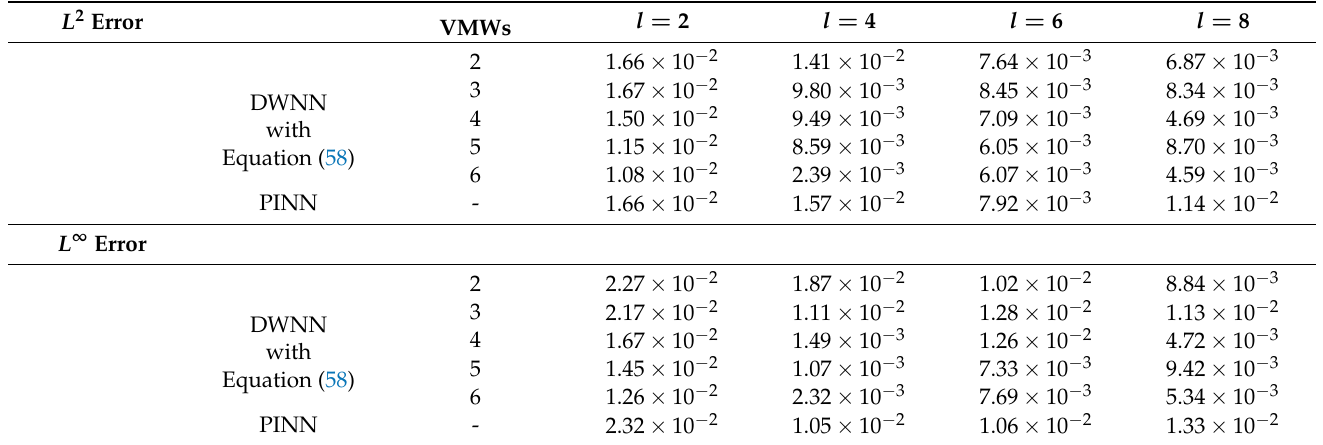
Table 8. The L 2 errors and L ∞ errors for 2D